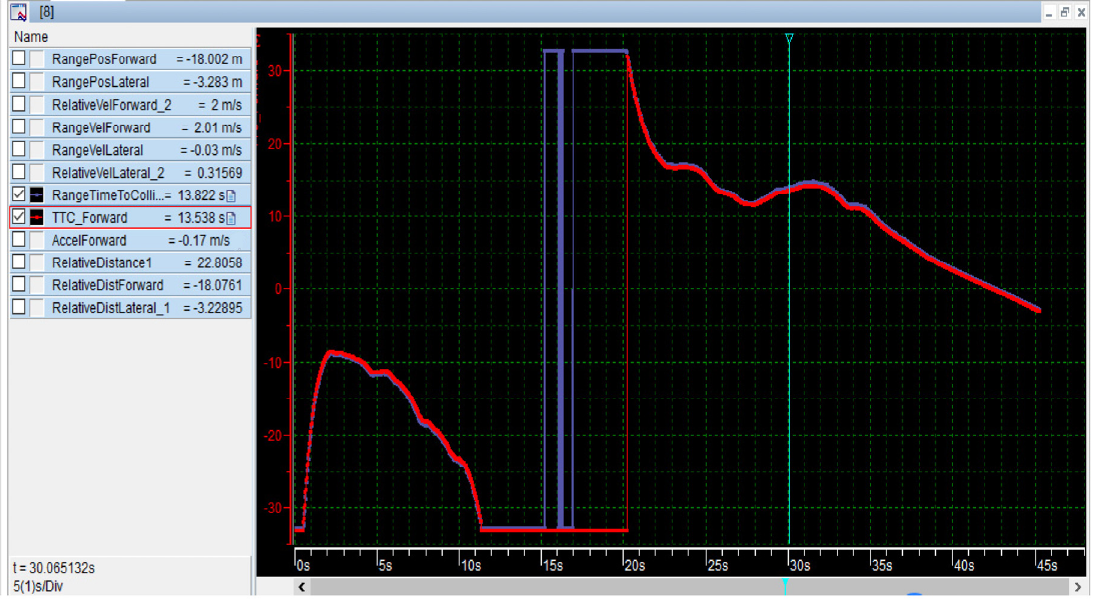
Figure 22. TTC_Forward of two vehicles. During the process of driving, the Dongfeng vehicle recognizes the traffic lights at